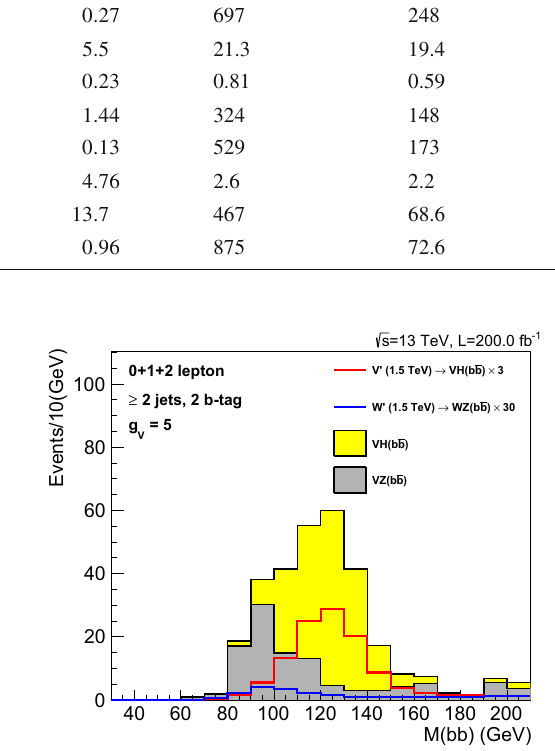
Fig. 8 Reconstructed bottom anti-bottom quark invariant mass for SM V H → (cid:3)(ν)(cid:3)(ν) b ¯ b and V Z → (cid:3)(ν)(cid:3)(ν) b ¯ b production (stacked yel- low and gray histograms, respectively), for an integrated luminosity of 200 fb − 1 . The HVT model predictions for M V (cid:3) = 1 . 5 TeV and g V = 4, with V H shown in red and W H in blue, are overlaid. The plot includes all final states with 0, 1 and 2 leptons. A p ⊥ > 300 GeV cut has been applied to the b ¯ b system